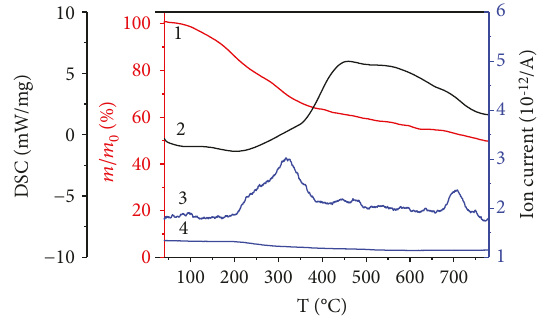
Figure 5: TG-DTA data for pristine ZnO fi lms deposited from nitrate bath at RT before their annealing at 500 ° C in